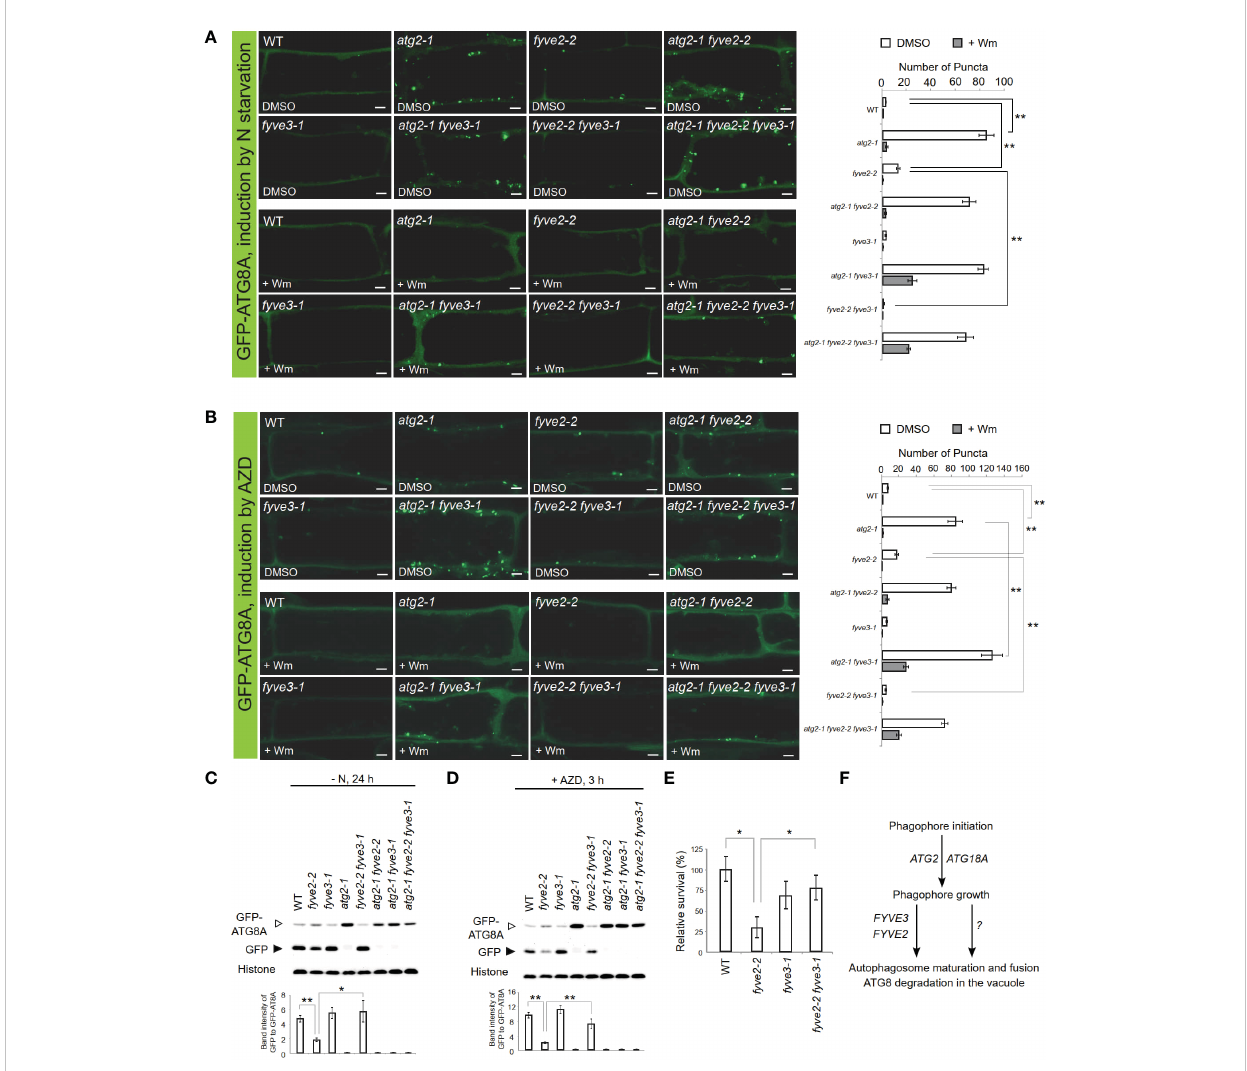
FIGURE 5 FYVE3 acts upstream of FYVE2 and downstream of ATG2 in a genetic pathway de fi ned by the autophagy marker GFP-ATG8A. (A, B) Representative confocal microscopy images (left) and quanti fi cation (right) of GFP-ATG8A puncta (arrows at the images) acquired from mature root cells with indicated genetic background. Arabidopsis transgenic seedlings expressing GFP-ATG8A were incubated in either nitrogen-lacking liquid media for 12 h (A) or nitrogen-suf fi cient liquid media containing AZD8055 for 1 h (B) , and treated with either wortmannin (Wm) or solvent control (DMSO) for 1 h prior to image acquisition. Scale bars = 5 µm. (C, D) , GFP-ATG8A cleavage immunoblot assays. Arabidopsis transgenic seedlings expressing GFP- ATG8A with various genetic backgroundsa were incubated in either nitrogen-lacking liquid media for 24 h (C) or nitrogen-suf fi cient liquid media containing AZD8055 for 3 h (D) prior to protein extraction. Quanti fi cation of relative protein band intensities is shown below. (E) Phenotypic analysis for fi xed-carbon starvation response. (F) A model for FYVE2 and FYVE3 functions in autophagosome dynamics. Columns marked with asterisks represent means that signi fi cantly differ from each other, according to the t -test. Mean ± S.E.; n = 14 to 16 images (A , B) , or 4 seedling populations (C , D , E) ; *0.01 < p < 0.05; **p <